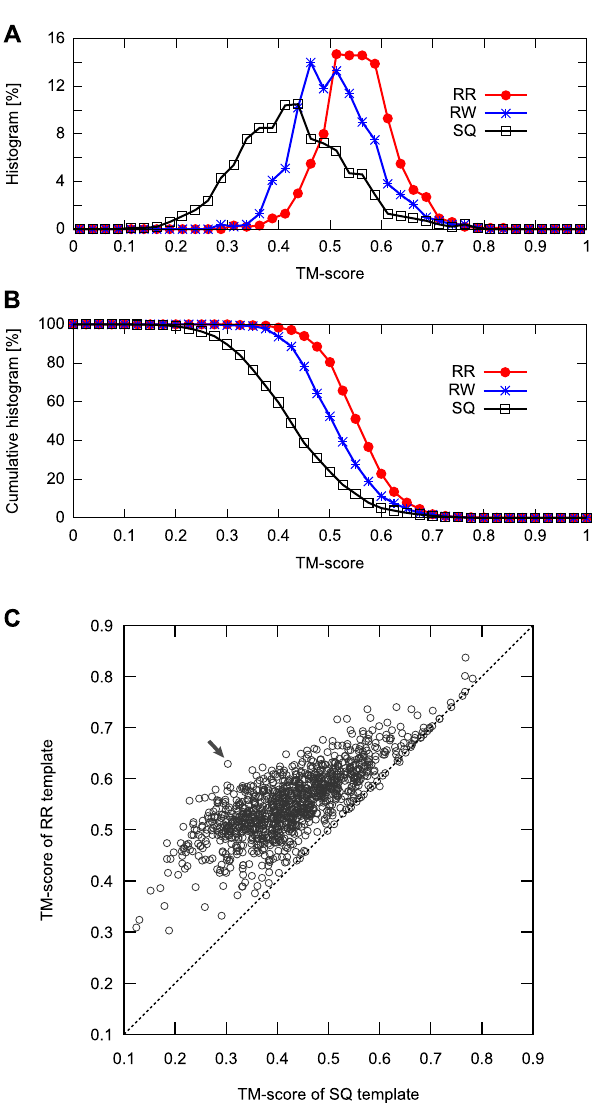
Figure 3. Comparison of the TM-scores among the best SQ, RW, or RR template and the corresponding query. (A) The histograms of the TM-scores of the SQ, RW and, RR templates are represented as black, blue, and red lines, respectively. (B) The cumulative histogram of the target proteins with the TM-scores of SQ, RW, and RR templates that is equal to or greater than the abscissa. (C) The scatter plot of the TM- scores of the SQ template versus RR template. The horizontal axis represents the TM-scores of SQ template, and the vertical axis represents those of the RR template. The black arrow indicates the target displaying the largest difference of TM-score between the SQ and RR templates.